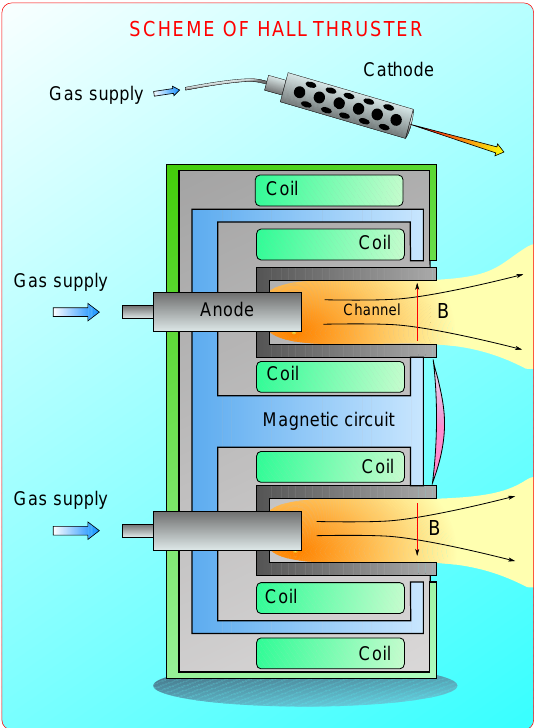
Figure 2. Various types of space electric propulsion systems utilize a vast variety of interdependent physical processes and design solutions. As an example, the electrostatic system is illustrated: Hall thrusters are among the major candidates for powering future spacecraft. Integration of electric propulsion thrusters into satellites represents an even more complex task due to the possible interac- tions of the thruster and plasma jets with sub-systems integrated within the satellite. For more details about the operation principles of Hall thrusters, see e.g. [23,24].